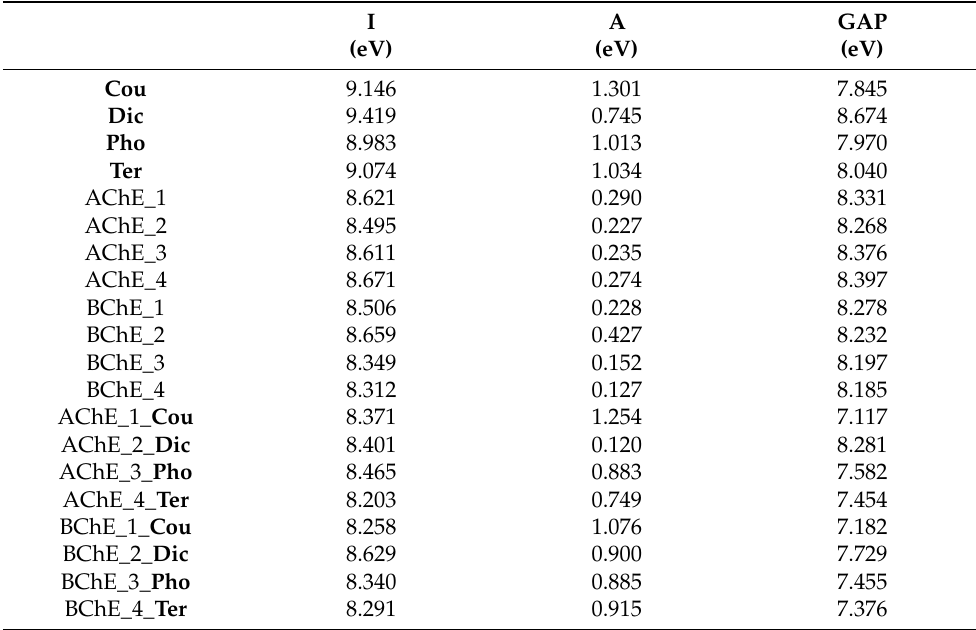
Table 2. The ionization potential (I = -HOMO), electron affinity (A = -LUMO), and energy gap (GAP = LUMO-HOMO) in the present study (in eV).